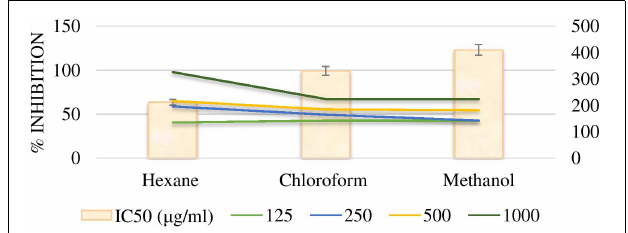
FIGURE 6 | %DPPH & IC 50 free radical scavenging activity of